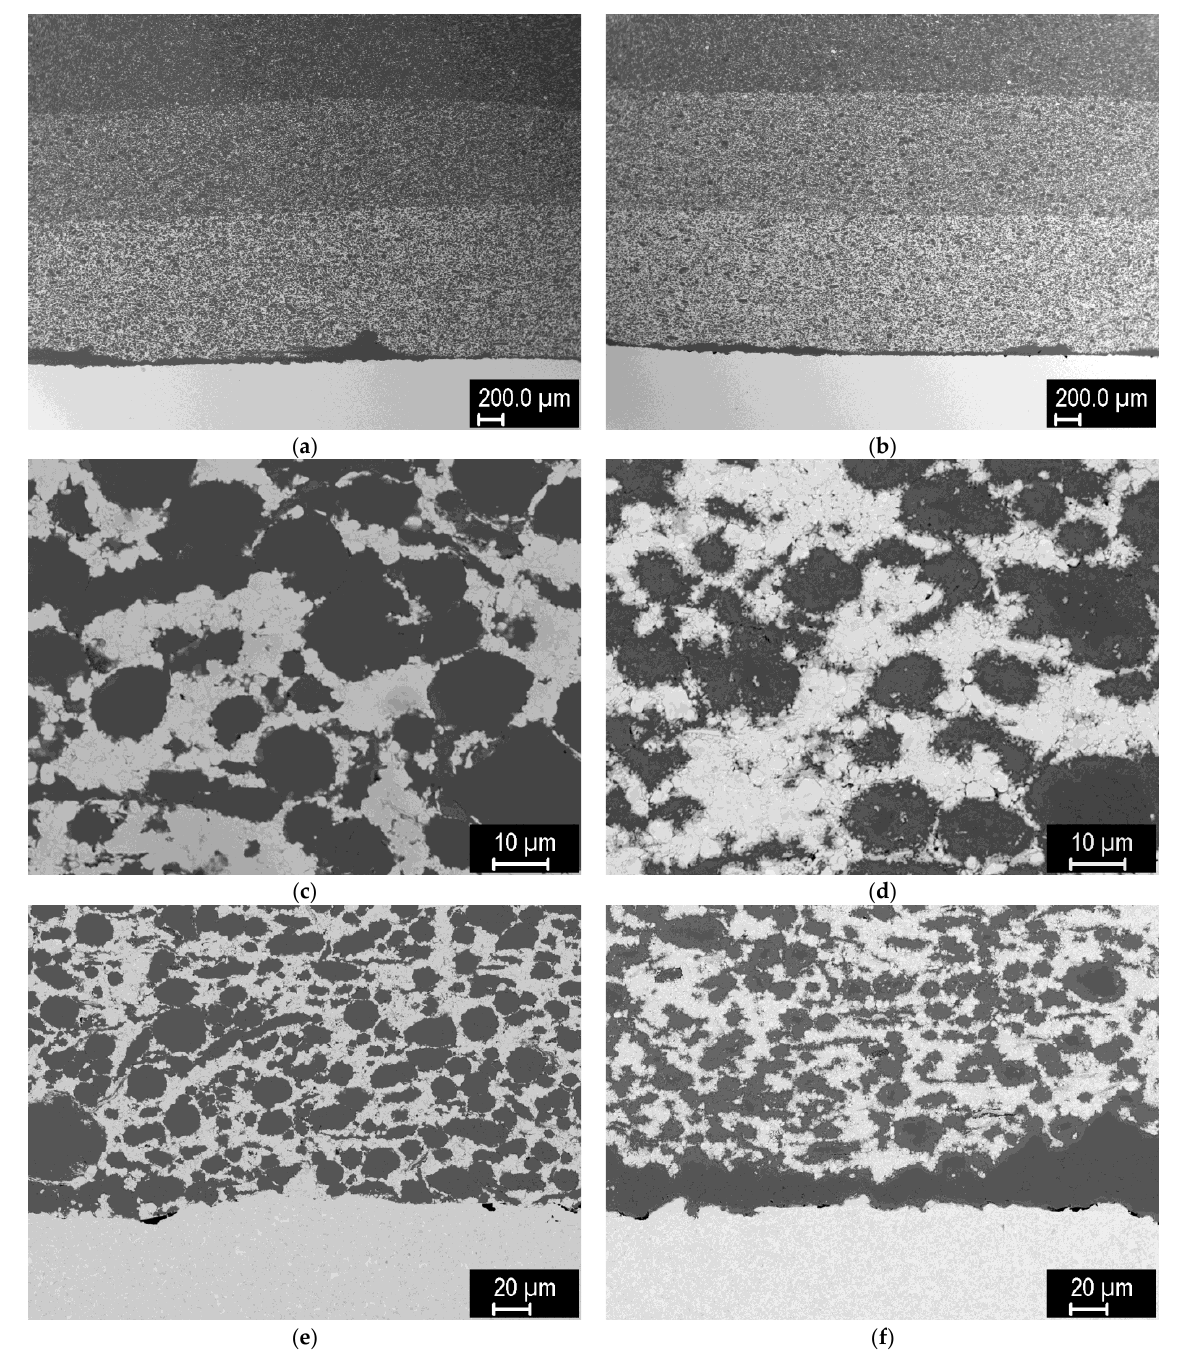
Figure 18. Tungsten pellet with a 3-layer FGM (60/40, 40/60 and 20/80 mixed layers with finer tung- sten powder and extended milling. ( a ) Overview, sintered at 1000 °C; ( b ) overview, sintered at 1100 °C; ( c ) detail of the composite layer, sintered at 1000 °C; ( d ) detail of the composite layer, sintered at 1100 °C; ( e ) detail of the composite-tungsten interface, sintered at 1000 °C; ( f ) detail of the composite- at 1100 ◦ C; ( c ) detail of the composite layer, sintered at 1000 ◦ C; ( d ) detail of the composite layer, tungsten interface, sintered at 1100 °C. sintered at 1100 ◦ C; ( e ) detail of the composite-tungsten interface, sintered at 1000 ◦ C; ( f ) detail of the composite-tungsten interface, sintered at 1100 ◦